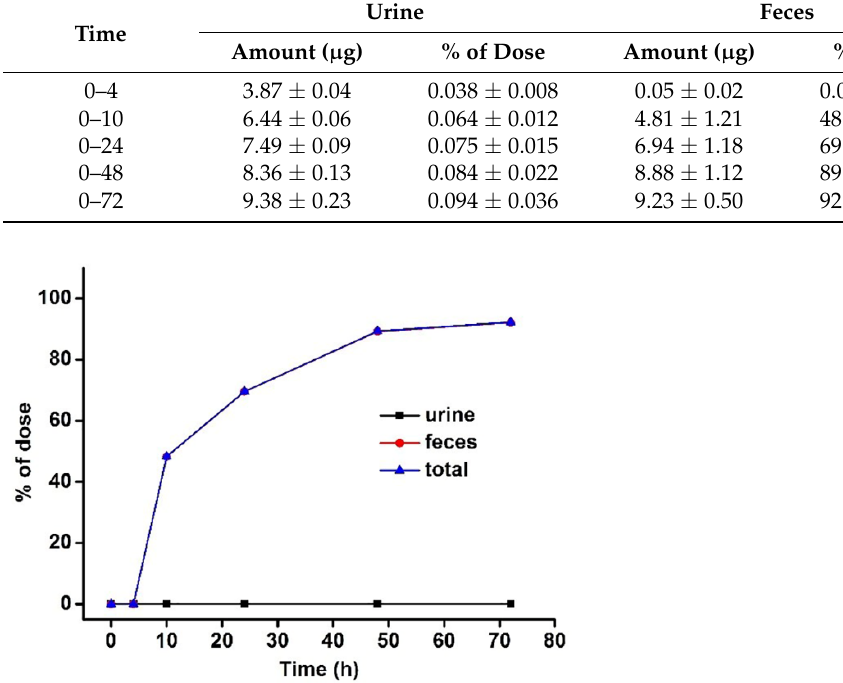
Table 7. Urinary and feces excretion rate of LBP-FITC after an oral dose of 50 mg/kg to rats. Table 6. Mean cumulative amounts of LBP-FITC excreted in urine and feces after an oral dose of 50 mg/kg to rats (Mean ± SD, n = 6).